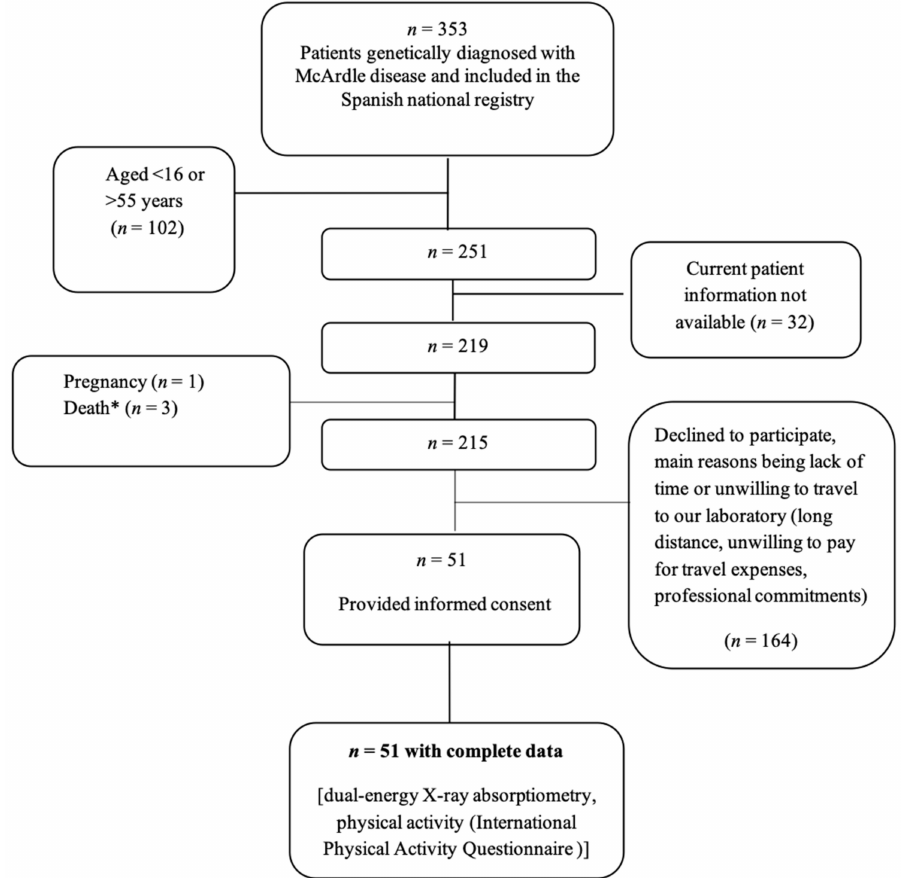
Figure 1. Flow diagram of patients with McArdle disease. * Death due to causes independent of McArdle disease (i.e., cardiovascular